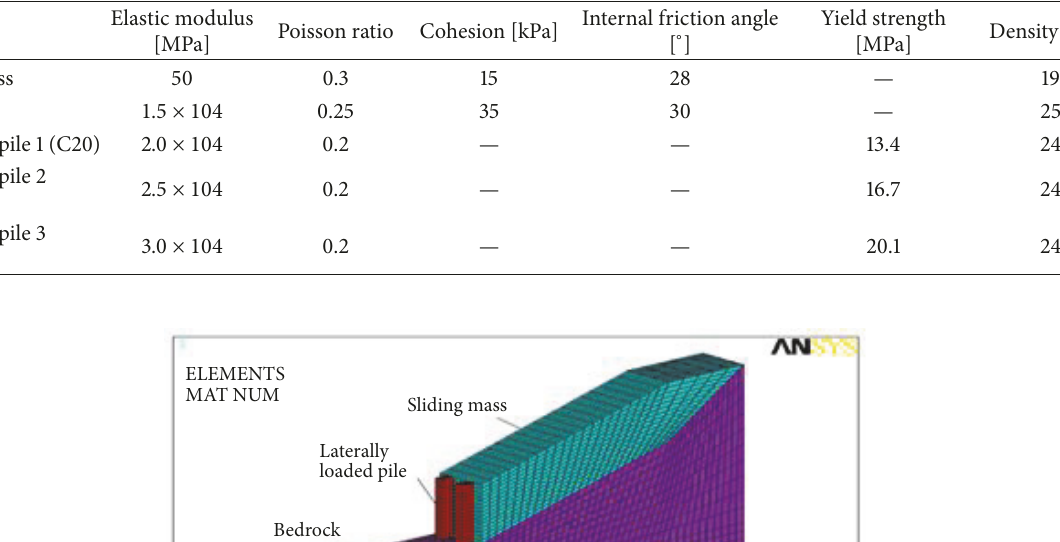
Table 1: The calculation parameters of stabilizing piles.